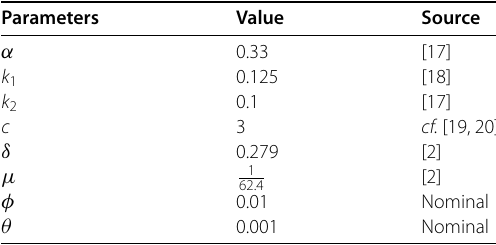
Table 1 The following parameters values are fixed